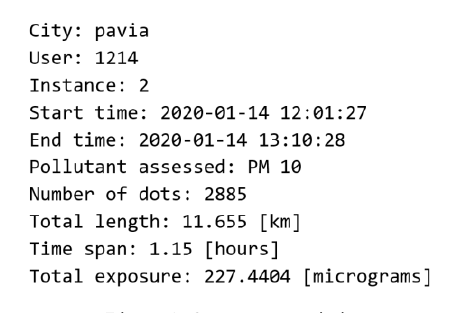
Figure 9. Summary